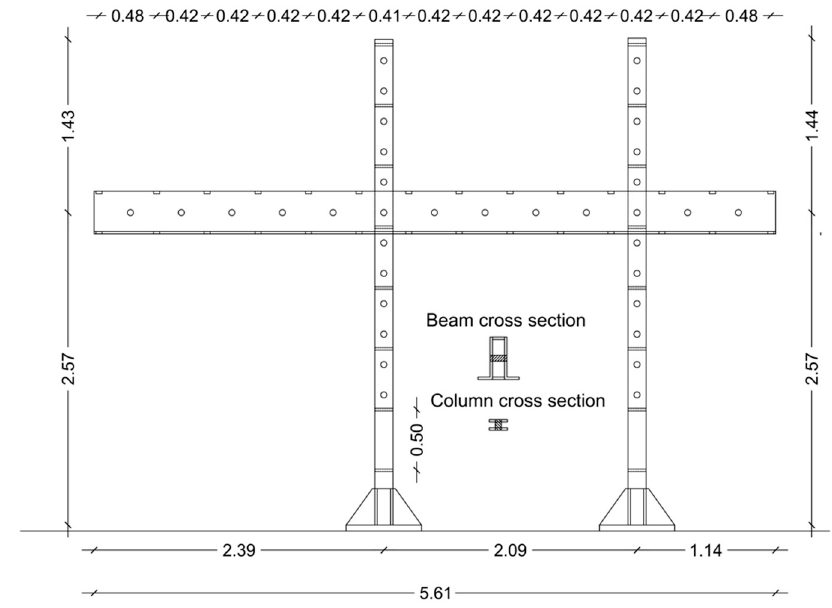
Figure 12. Steel frame picture ( top ) and geometrical dimensions ( bottom ), measures are in m.